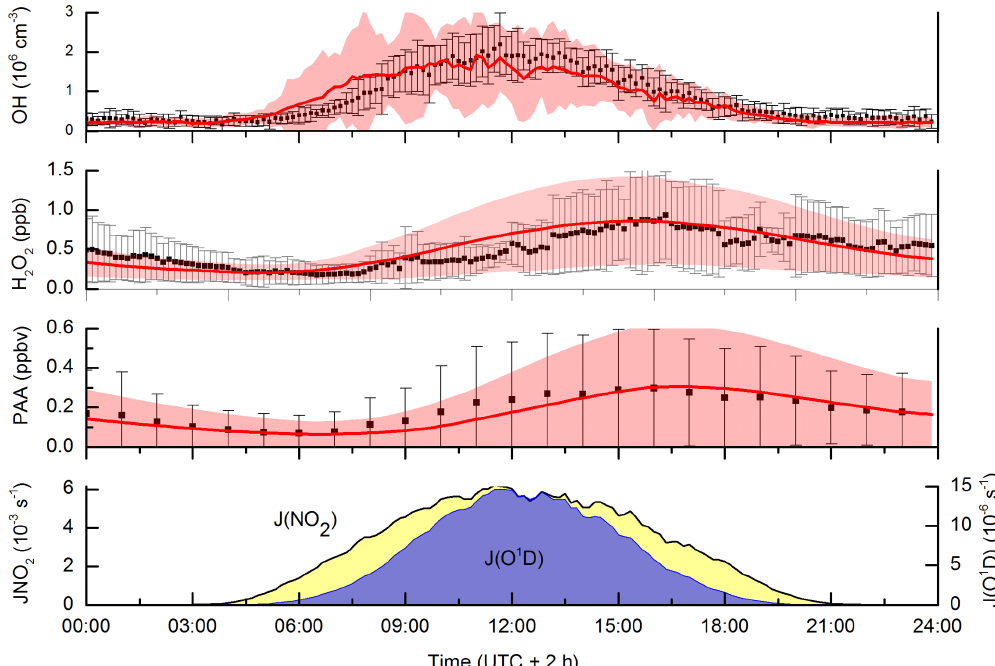
Figure 8. Campaign-averaged (days 202 to 220) diel profiles of OH, PAA and H 2 O 2 . Measurements are black data points, error bars are 1 σ variability. Model results are the red lines with the shaded area representing 1 σ variability. The diel-averaged photolysis rate constants of NO 2 and O( 1 D) are displayed as indicators of photochemical